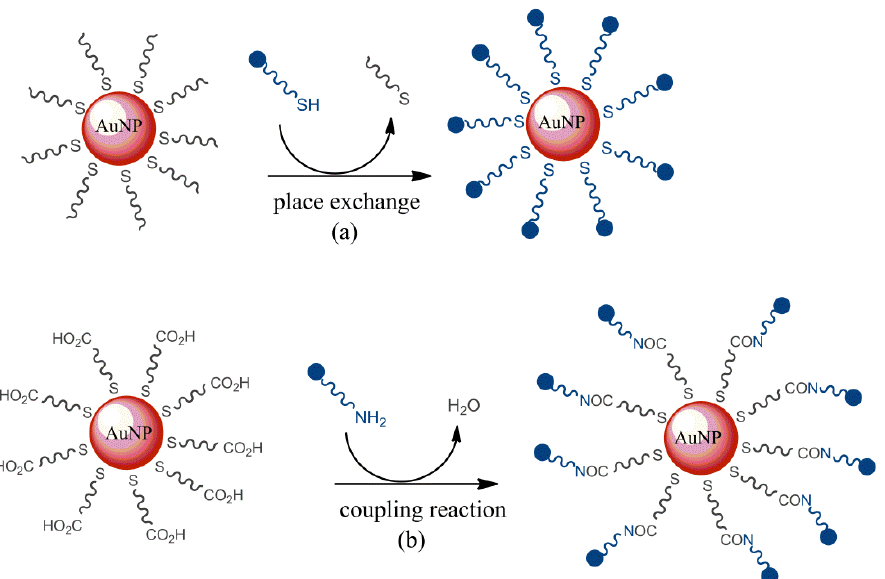
Figure 4. Representation scheme of the surface functionalization method through ( a ) a place exchange and ( b ) coupling reaction.